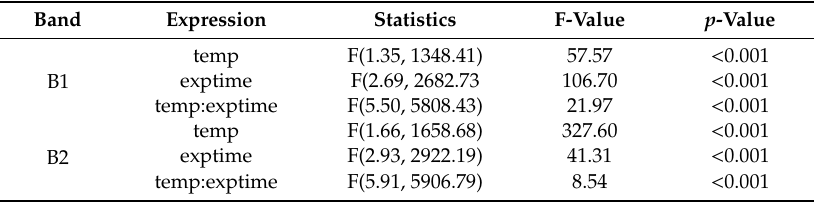
Table 4. The repeated measures analysis of variance (ANOVA) table of ambient temperature (temp) and exposure time (exptime) upon image noise. The column statistics shows degrees of freedom after Greenhouse-Geisser correction. The F value column represents the values of test statistics for each model term, p value represents the test significance for this term.